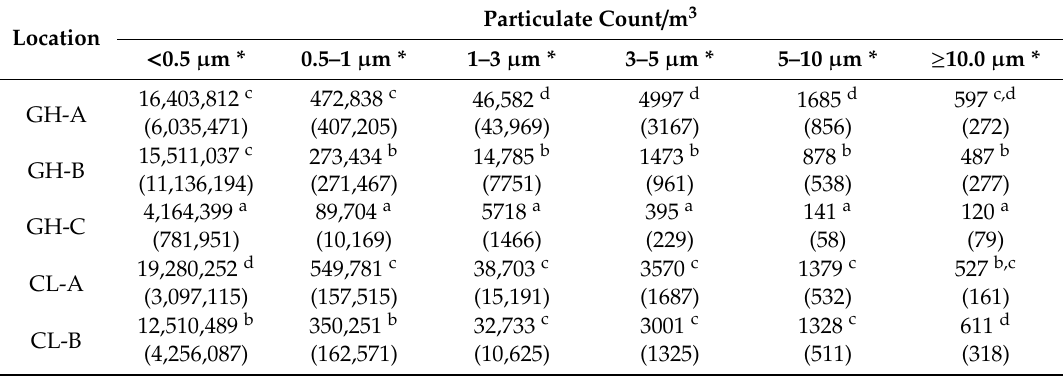
Table 2. Mean (SD) of particle numbers in the six size